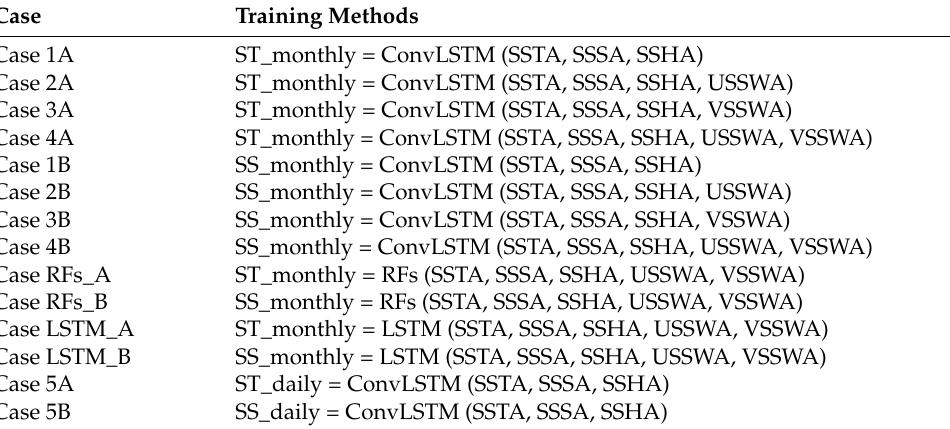
Table 2. Design of